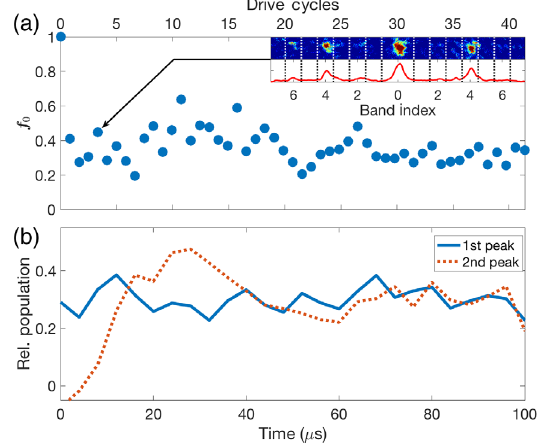
FIG. 3. Entering the prethermal state. (a) Normalized ground- band occupation f 0 as a function of time during modulation with α ¼ 3 , Ω ¼ 2 . 6 , a ¼ 0 . The system attains the prethermal value of f 0 on timescales comparable to a single drive cycle. These data are reproduced from the rightmost panel of Fig. 2(c) to facilitate direct comparison with Fig. 3(b). Inset shows a sample band- mapped image and its column integration for the indicated data point, with Brillouin zone boundaries and band indices labeled. (b) Population fraction in diffracted peaks after diabatic lattice snapoff, as a function of time during the same drive. x axes are the same for the two plots. Gradual attainment of the prethermal steady state is apparent in the settling of the second-peak